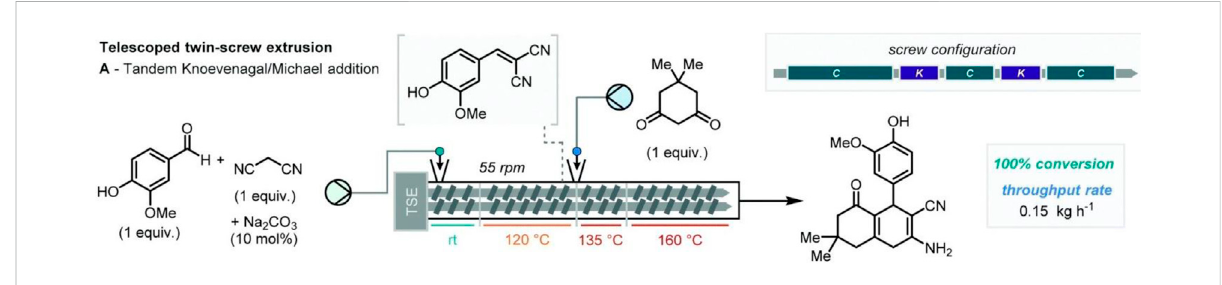
FIGURE 2 Telescopedcascadeprocessesthroughreactivetweenextrusion.Reproducedfrom(Boltetal.,2022)withpermissionfromtheRoyalSocietyof